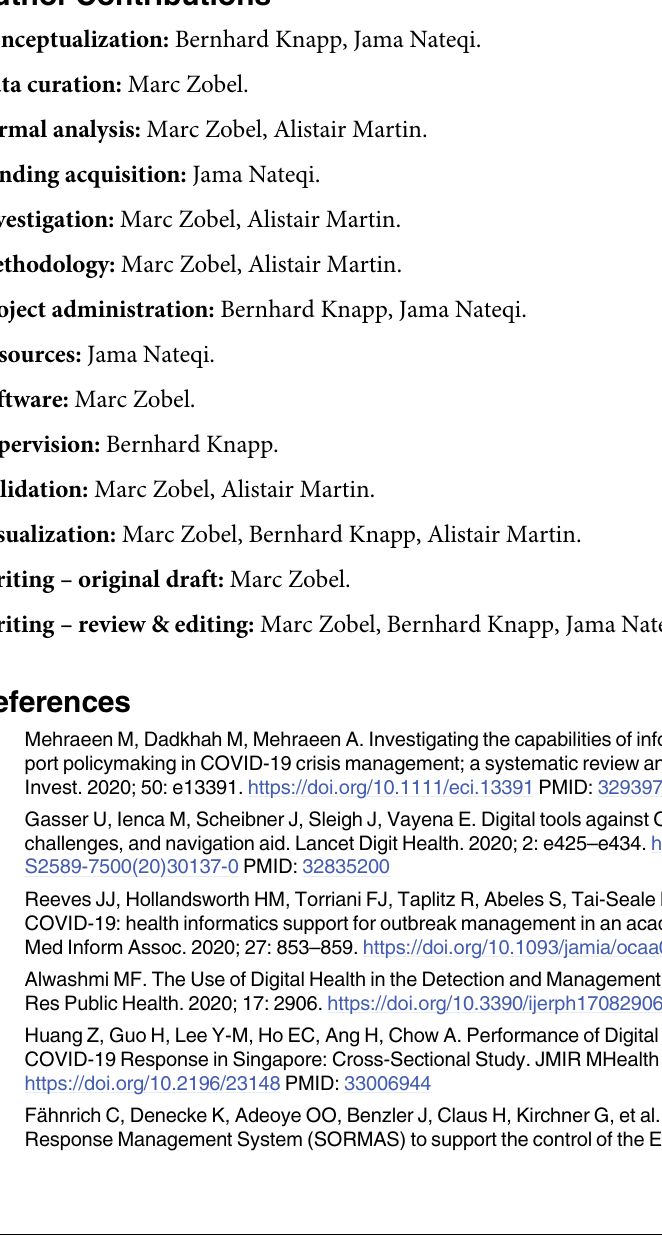
S1 Table. QOL metrics, correlations, and shifted